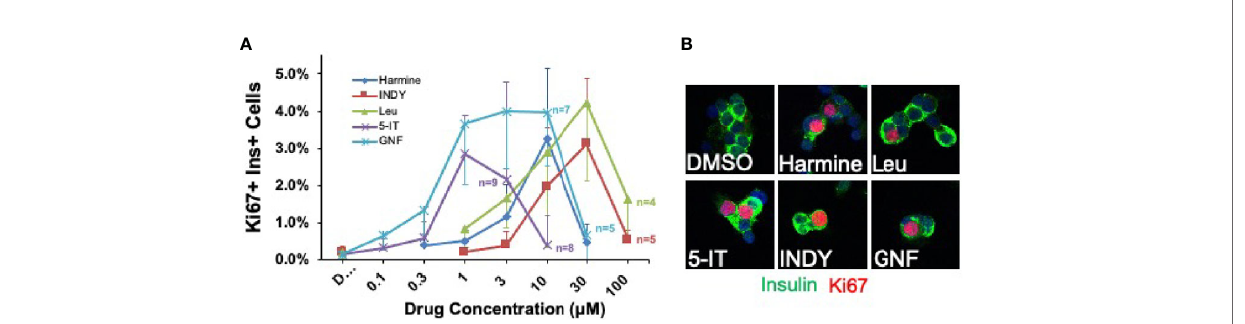
FIGURE 4 | Head-to-Head Comparison of Lead Beta Cell Regenerative Drugs. (A) Five most widely studied DYRK1A inhibitors were directly compared in the same cadaveric donor islets. Each line represents a dose-response curve in the same islet preparations assayed at the same time at the concentrations shown. The same 10 adult human islet preparations were used for all data points, except in cases where suf fi cient human islets were not available to assay all drugs at every dose: in these cases, the number of human islet preparations used at a given dose is indicated. Several points are important. First, there typically is great variability among human islet preparations, as illustrated here by the large error bars (SEM). Second, GNF4877 and 5-IT are the most potent in driving human beta cell proliferation, followed by harmine and leucettine and INDY. Third, the maximum ef fi cacy in inducing proliferation is similar for all DYRK1A inhibitors. Fourth, all compounds inhibit human beta cell proliferation at higher doses, suggesting that they interfere, at higher doses, with important cell cycle activation pathways. Compare to Figure 10 below. (B) Both panels are adapted with permission from (51), where statistical details and fi ndings with additional DYRK1A inhibitors can be